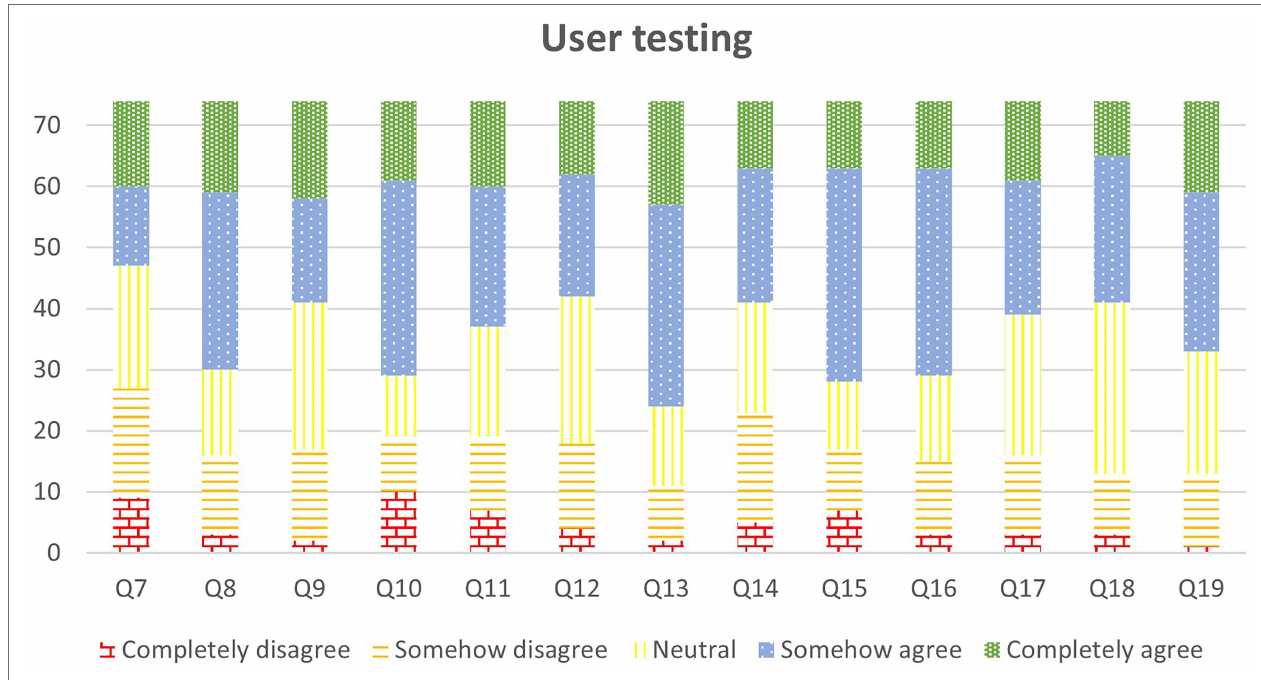
FIGURE 13 | User testing